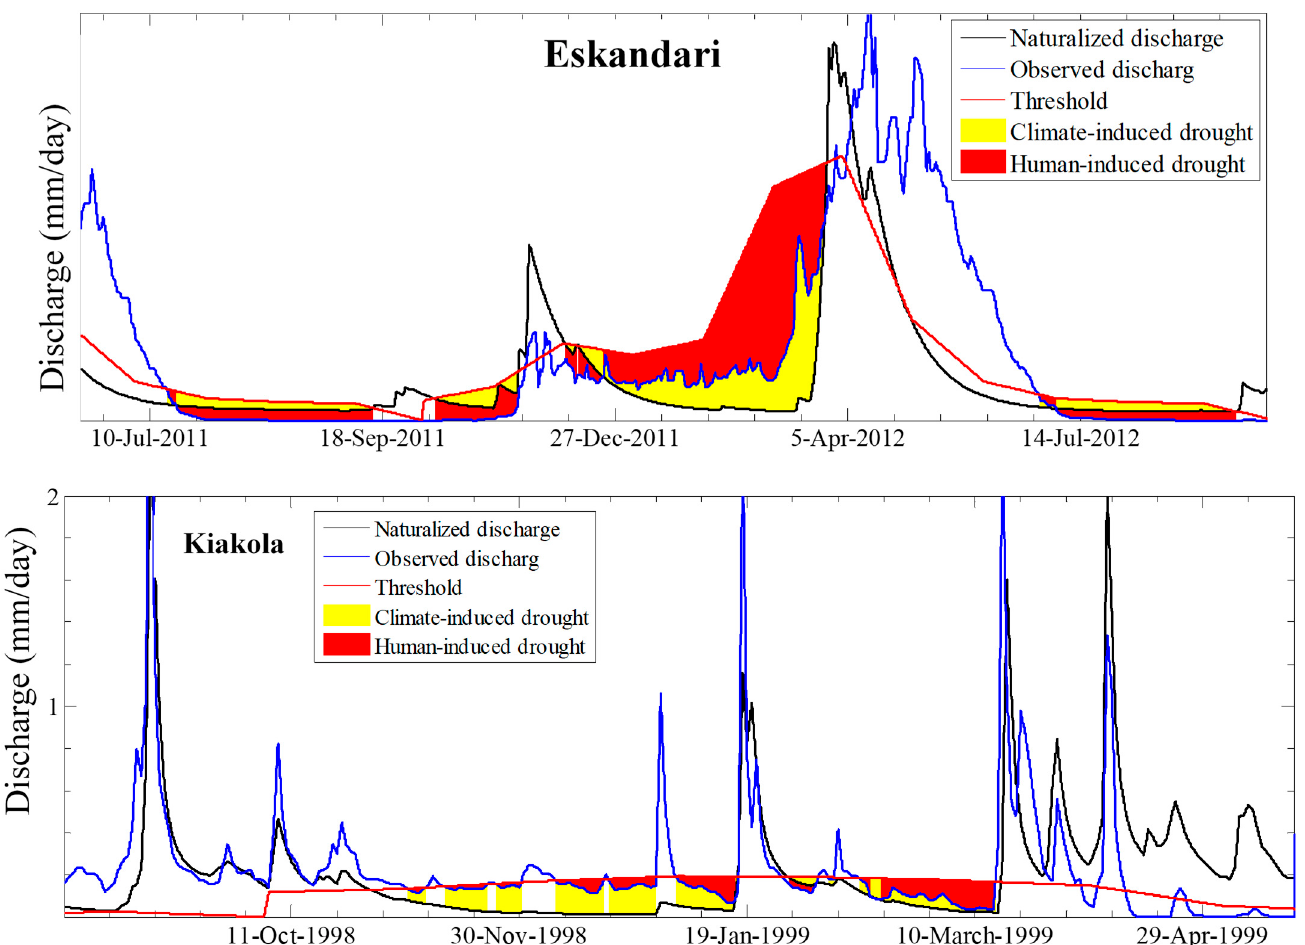
Figure 10. Examples of human-modified droughts.